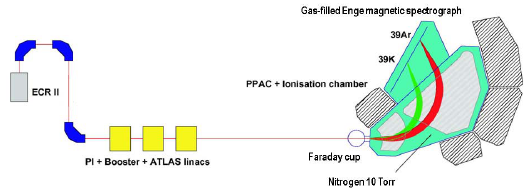
Figure 6. (top) γ -ray spectrum of the 147 Pm target after activation recorded at a distance of 55 mm from the HPGe detector with the absorber configuration described in the text; (bottom) zoom in regions of the 1013.8 and 1465.12 keV photopeaks from the decay of 148 m Pm and 148 g Pm, respectively.